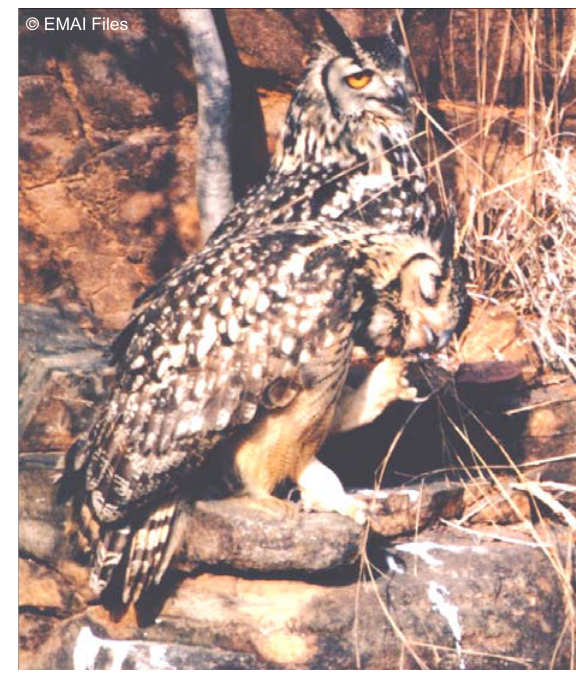
Image 11. Head scratching and preening (the male is in the